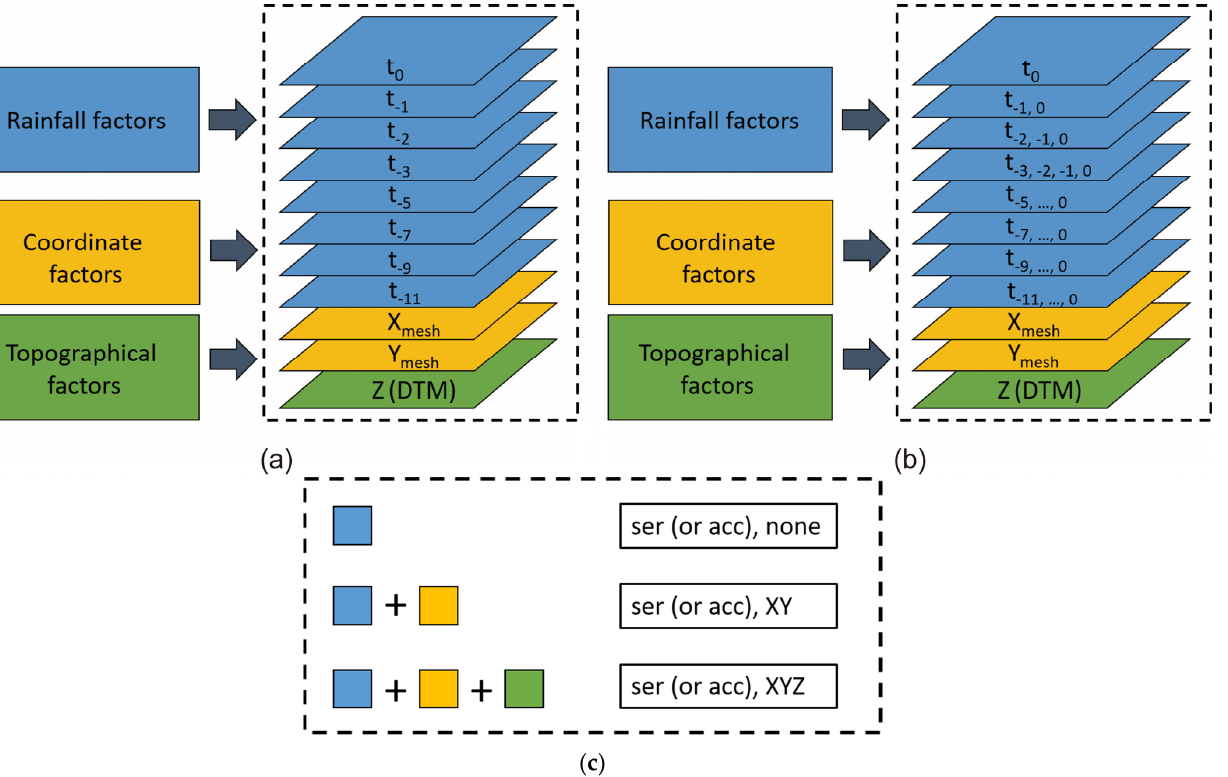
Figure 7. Combination classification of: ( a ) rainfall data in different time series (ser), coordinates (XY), and elevation (Z); and ( b ) cumulative rainfall data in different periods (acc), coordinates (XY), and elevation (Z). ( c ) Combination of different physical factors.